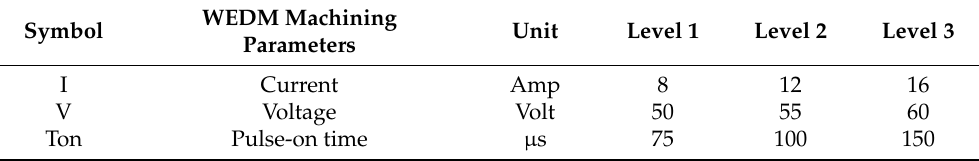
Table 4. Levels of process parameters for DOE.